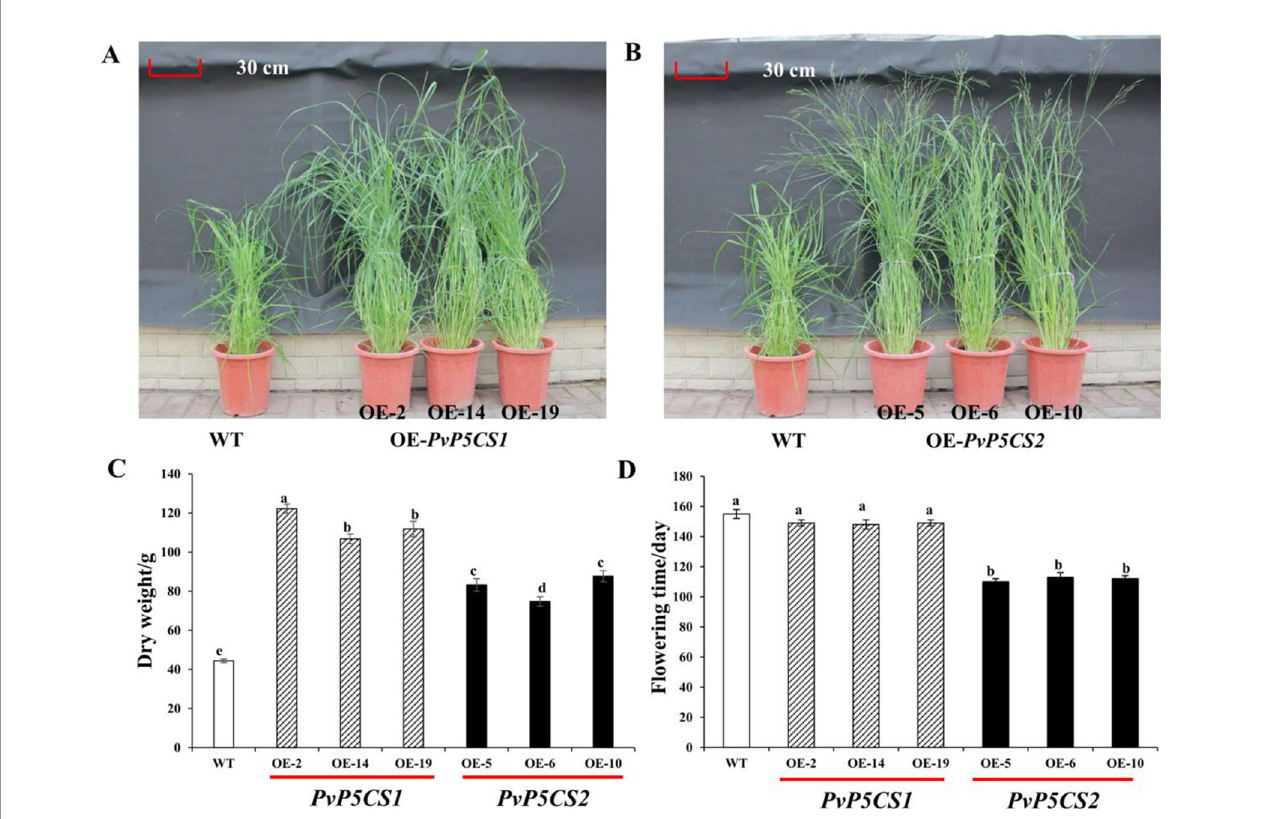
FIGURE 3 | Phenotypic comparation and biomass analysis among PvP5CS OE transgenic plants. Phenotypes of three independent transgenic lines overexpressing PvP5CS1 (A) and PvP5CS2 (B) . Total above ground dry weight of transgenic lines overexpressing PvP5CS genes (C) . Flowering time in OE- PvP5CS1 and OE- PvP5CS2 transgenic switchgrass lines (D) . Data are mean values of three biological repeat, and signi fi cance of treatments was tested at the P < 0.05 level (one way ANOVA, Dunnett's